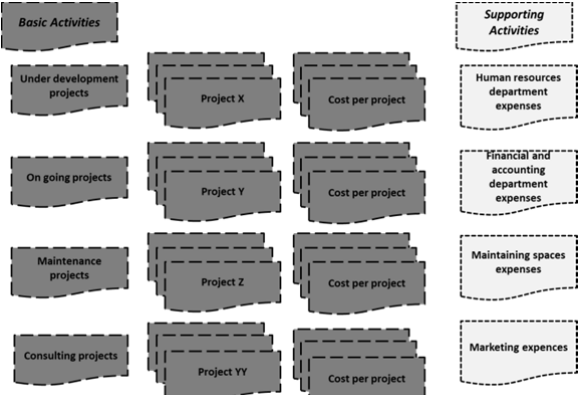
Figure 1 . Model of cost system